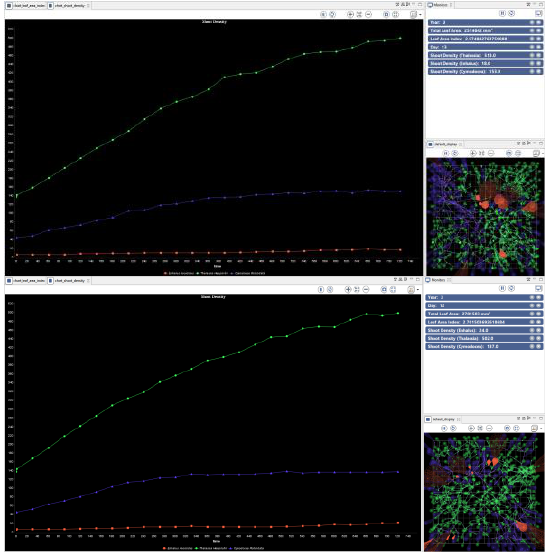
Figure 5. Screenshots of shoot density graph, values and seagrass